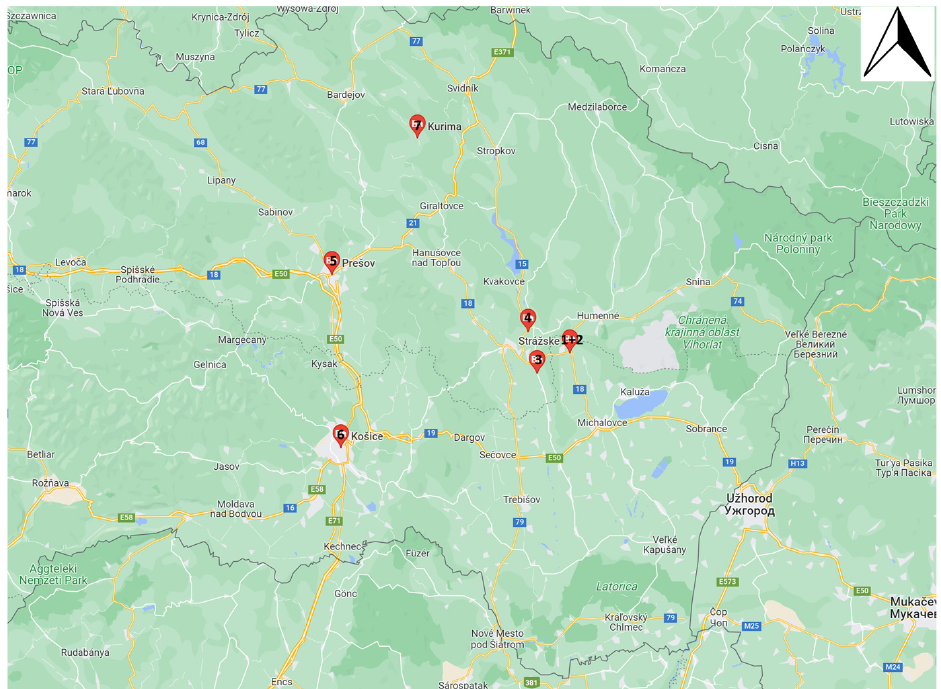
Figure 4. Map with sampling regions in Slovakia.